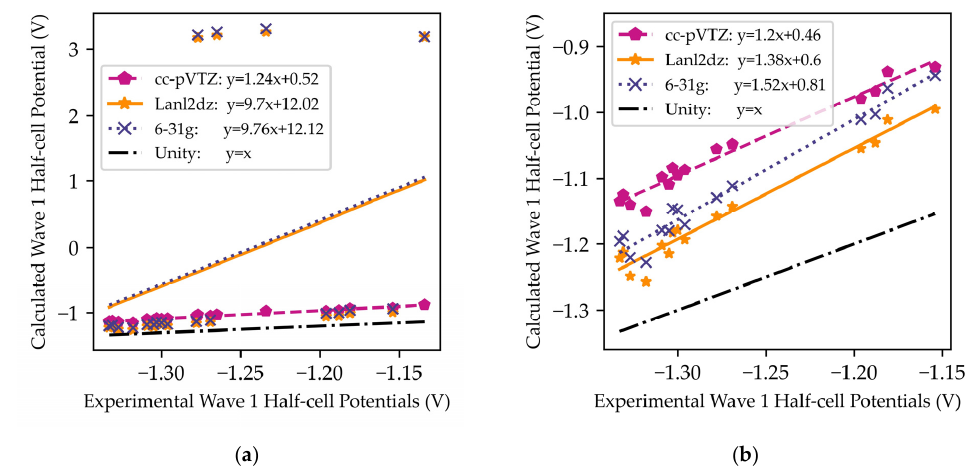
Figure 5. Comparison of computational electrochemical cell potentials vs. experimental [31] electro- chemical cell potentials for ( a ) wave 1 and ( b ) wave 1 with the nitro group containing derivatives (E1–E4) removed from analysis. The B3LYP/cc-pVTZ method is indicated by pink pentagons and the previously calculated methods B3LYP/lanl2dz and B3LYP/6-31G [27] are indicated with blue crosses and yellow stars, respectively. Derivative C3 is excluded from analysis.